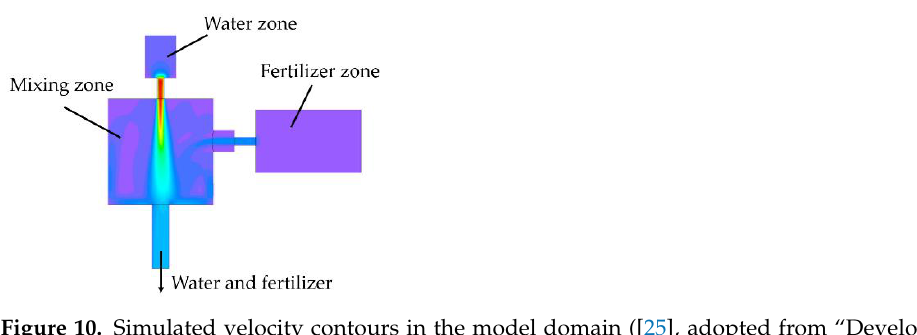
Figure 9. The commercial sprayer mounted with a high-pressure injection system ([36], adopted from “Injection methods to reduce ammonia emission from volatile liquid fertilisers applied to growing crops” with permission from Elsevier, 2022).